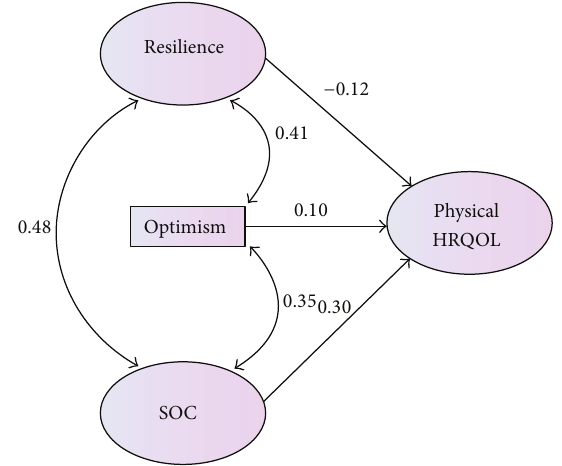
Figure 2: Note . SOC = sense of coherence; HRQOL = health related quality of life.